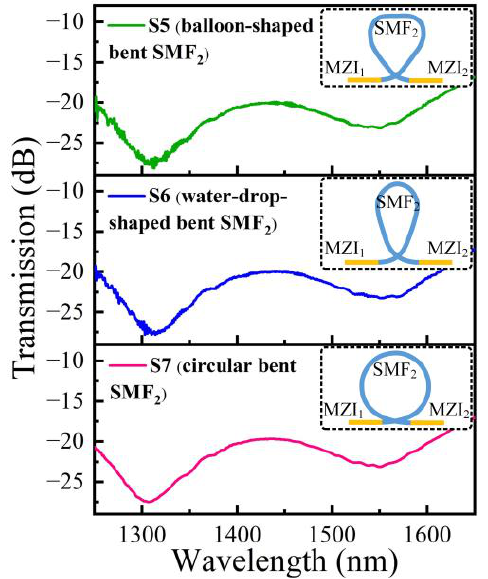
Figure 6. Transmission spectra of three fabricated cascaded MZI samples S5, S6, and S7 with varying bending ways of 20 cm long transmission SMF (i.e., SMF 2 ) between MZI 1 and MZI 2 .